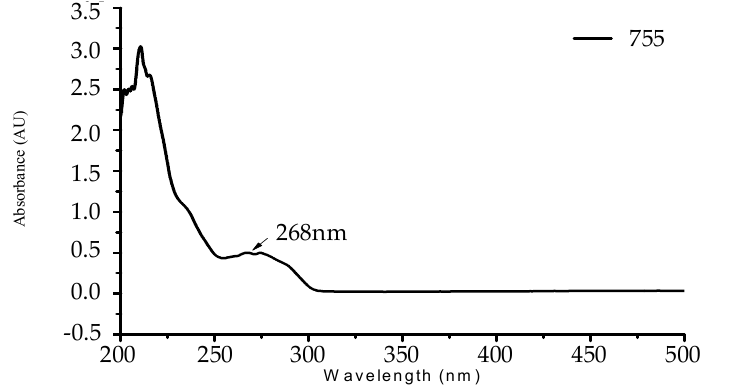
Figure 5. Microcapsules of alginate/tea tree essential oil.